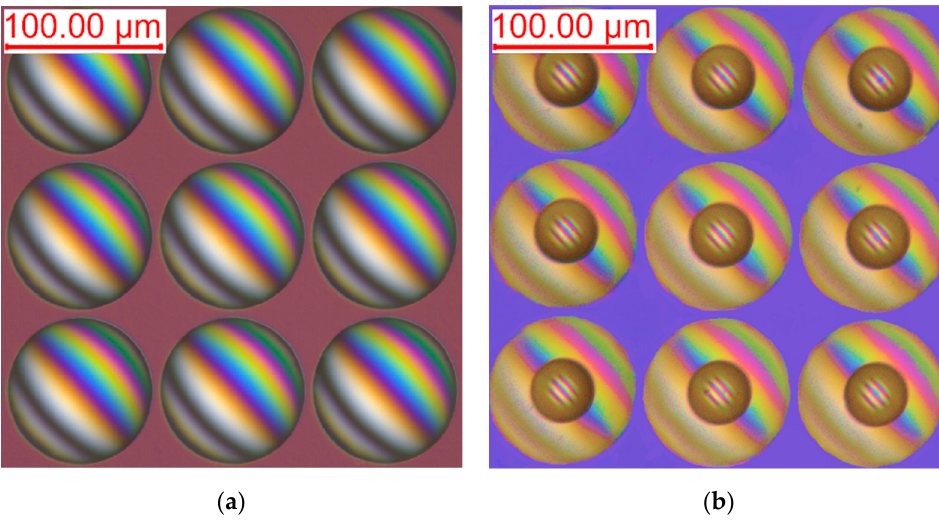
Figure 6. The morphology of the MLLA detected using a differential interference microscope. ( a ) The morphology of microlens array in the lower layer. ( b ) The structure of the MLLA.